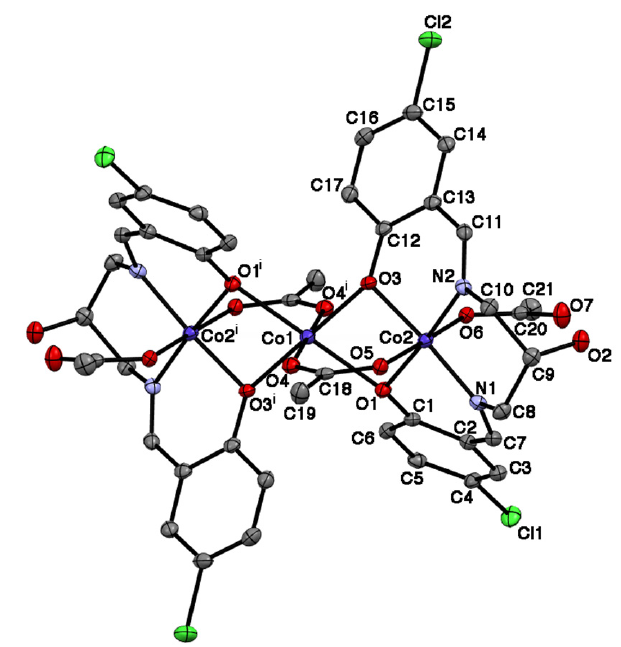
Figure 5. The ORTEP view of the molecular structure of [Co 3 (Hclsalpr) 2 (CH 3 COO) 4 ] with thermal ellipsoids (50% probability level). The hydrogen atoms have been omitted for clarity.